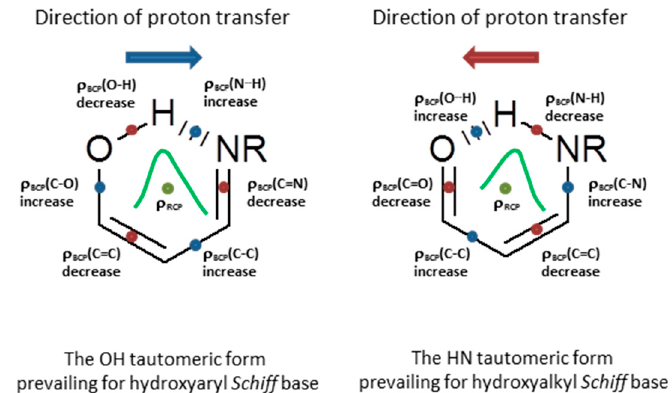
Figure 4. The scheme of electron-density topological changes in quasi -aromatic hydrogen bonding under the proton transfer process in the hydrogen bridge; on the left—for the compounds with the prevailing enol-imine form (the hydroxyaryl Schiff bases ( I )), on the right—for those with the prevailing keto-amine form (the hydroxyalkyl Schiff bases ( II )). Ref. [29] – Adapted by permission of The Royal Society of Chemistry.